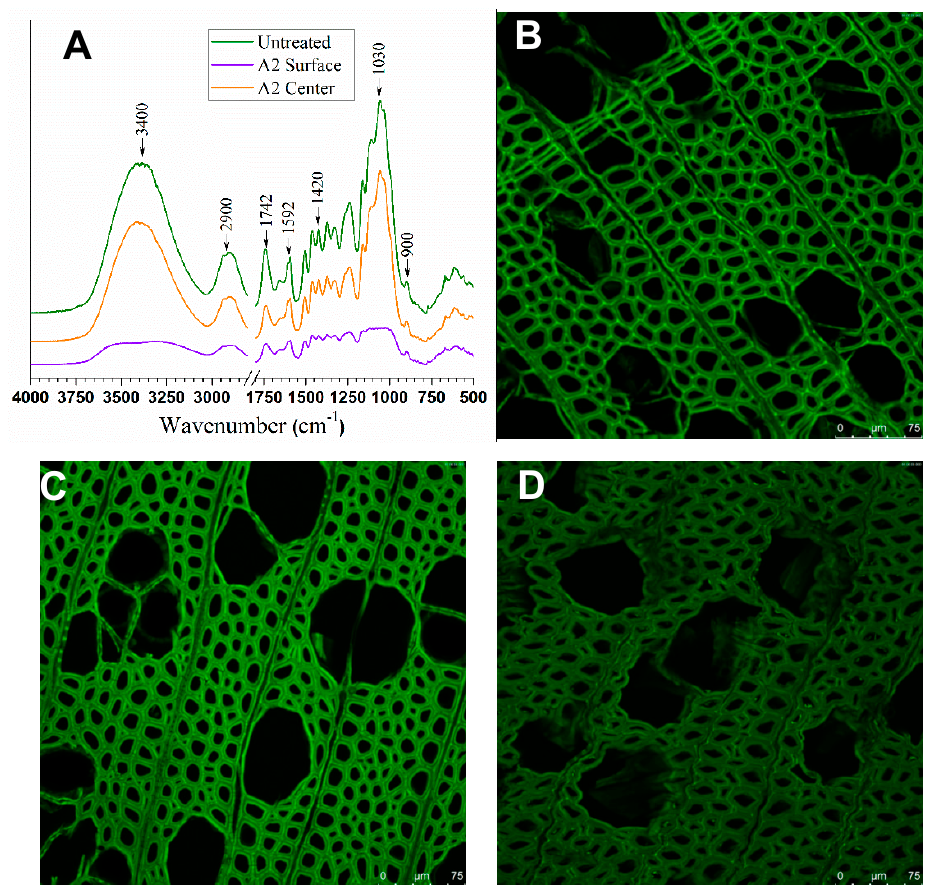
Figure 3. ( A ): The FTIR spectra of an untreated wood sample, and wood sections from surface and center layers of A2 ; ( B – D ): The fluorescence image (with an excitation wavelength at 405 nm) of lignin in an untreated wood sample; ( B ) the center layer ( C ) and surface layer ( D ) of alkali-treated A2. Scale bars = 75 μ m.